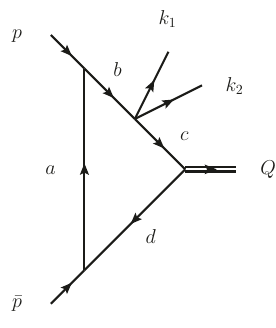
Figure 3 . A particular master diagram, with internal lines labelled for